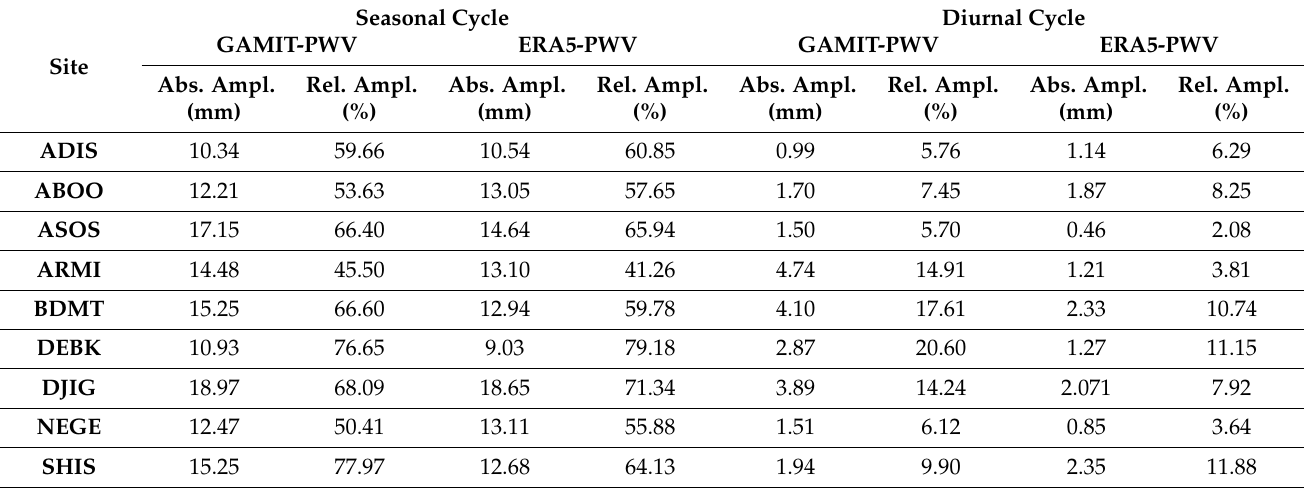
Table 5. Absolute and relative amplitude of the seasonal and diurnal cycles for GAMIT-PWV and ERA5-PWV